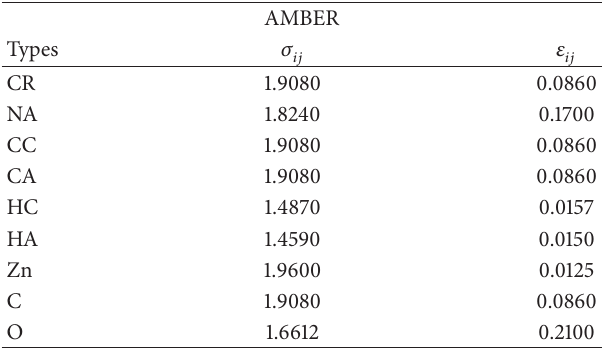
Table 3: The parameters 𝜀 𝑖𝑗 and 𝜎 𝑖𝑗 of AMBER force